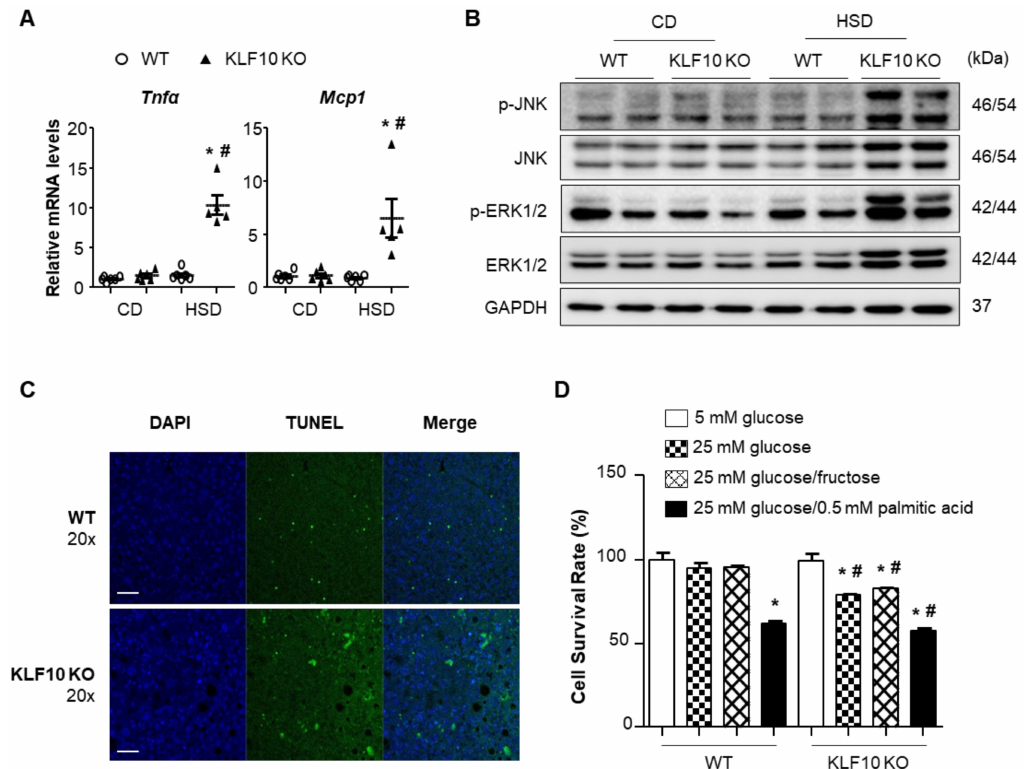
Figure 5. High sucrose diet activates stress-mediated inflammation and cell death in Klf 10 KO mouse livers. Eight-week-old WT and Klf 10 KO mice were fed either CD or HSD for eight weeks ( n = 5–6 mice/group). ( A ) Relative mRNA levels of proinflammatory cytokines Tnf α and Mcp 1 in the liver were analyzed via qPCR. * p < 0.05 vs. genotype-matched, CD-fed group and # p < 0.05 vs. diet-matched, genotype control. ( B ) Western blot analysis of p-JNK, JNK, p-ERK1/2, and ERK1/2, in the livers of WT and Klf 10 KO mice fed either CD or HSD. ( C ) Representative images of the TUNEL assay were used to confirm the induction of apoptosis in the liver sections (Scale bars: 50 µ m, Magnification: 20 × ). ( D ) Primary hepatocytes were isolated from WT and Klf 10 KO mice. The CCK-8 assay determined the cell viability of primary hepatocytes following treatment with 5 mM glucose, 25 mM glucose, 25 mM glucose/fructose, or 25 mM glucose with 0.5 mM palmitic acid for 24 h. * p < 0.05 vs. 5 mM glucose group. # p < 0.05 vs. treatment-matched. All data are representative of at least three independent experiments and expressed as mean ± SEM. Charts were produced using GraphPad Prism 5.0. Statistical differences were determined by two-way ANOVA with Mann–Whitney U test using SPSS v17.0. WT, wild type;